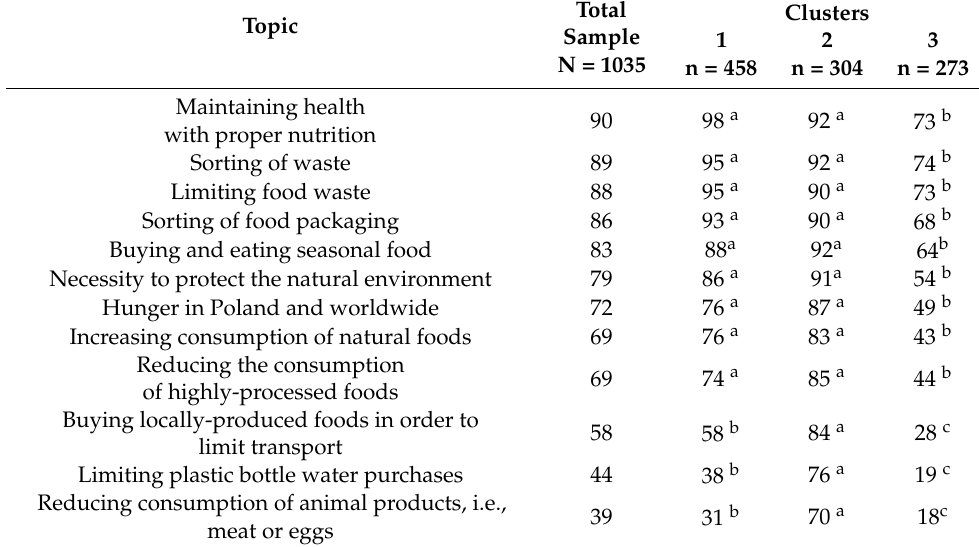
Table 4. Topics raised by parents with their 6–8 year-old children